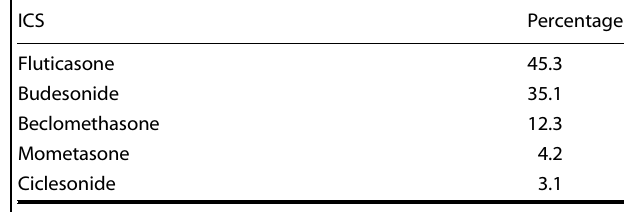
Table 1. Patient demographics in patients with COPD using ICS and Table 2. Concomitant ICS used by the ICS